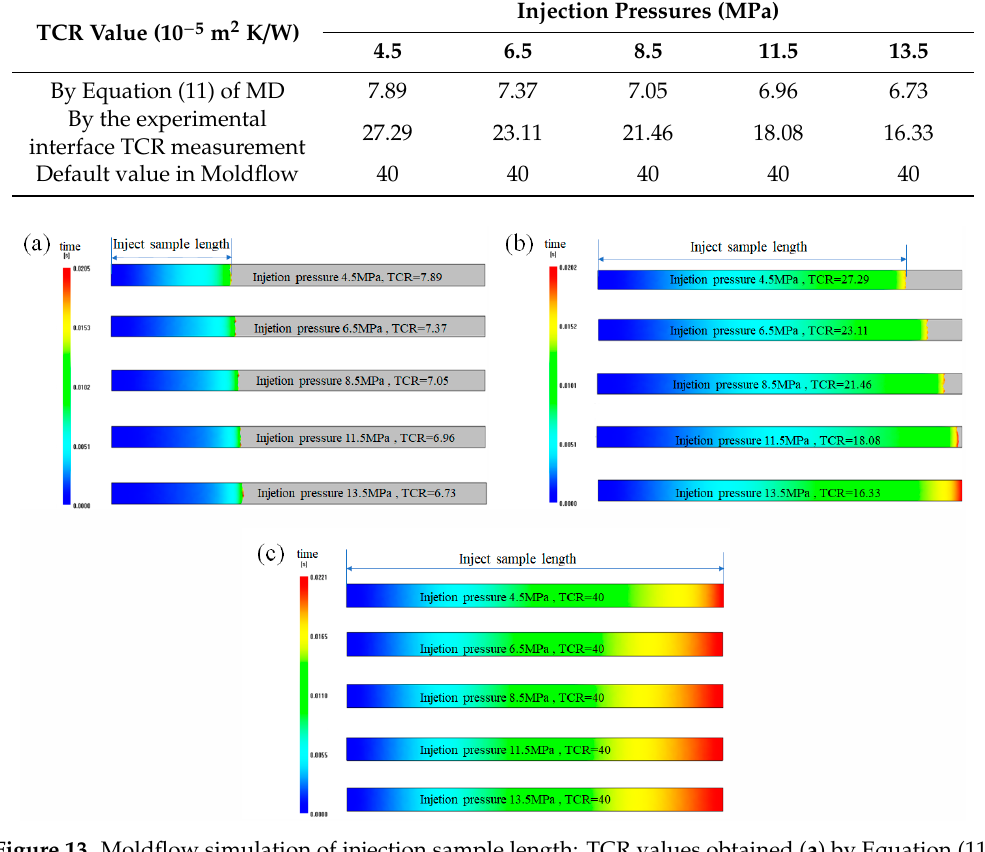
Figure 13. Moldflow simulation of injection sample length: TCR values obtained ( a ) by Equation (11) of MD, ( b ) by the experimental interface TCR measurement and ( c ) by default value in Moldflow.